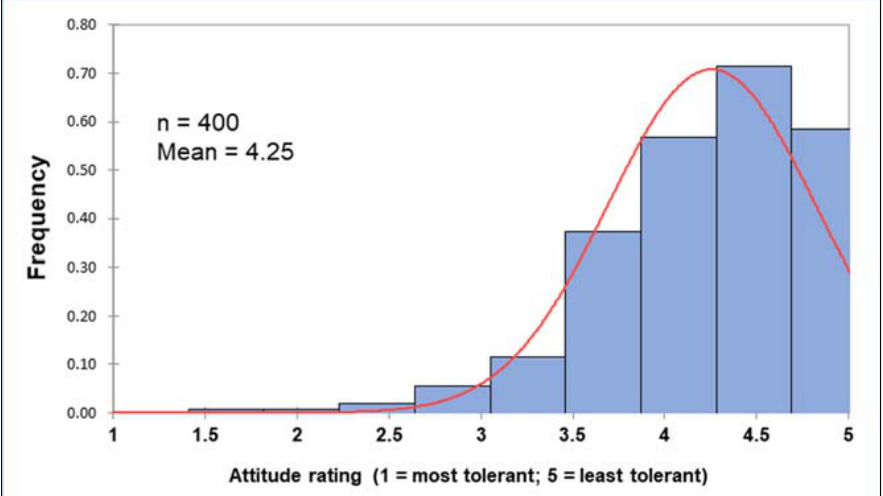
Figure 1. Attitudes among home ‐ based Cameroonians.